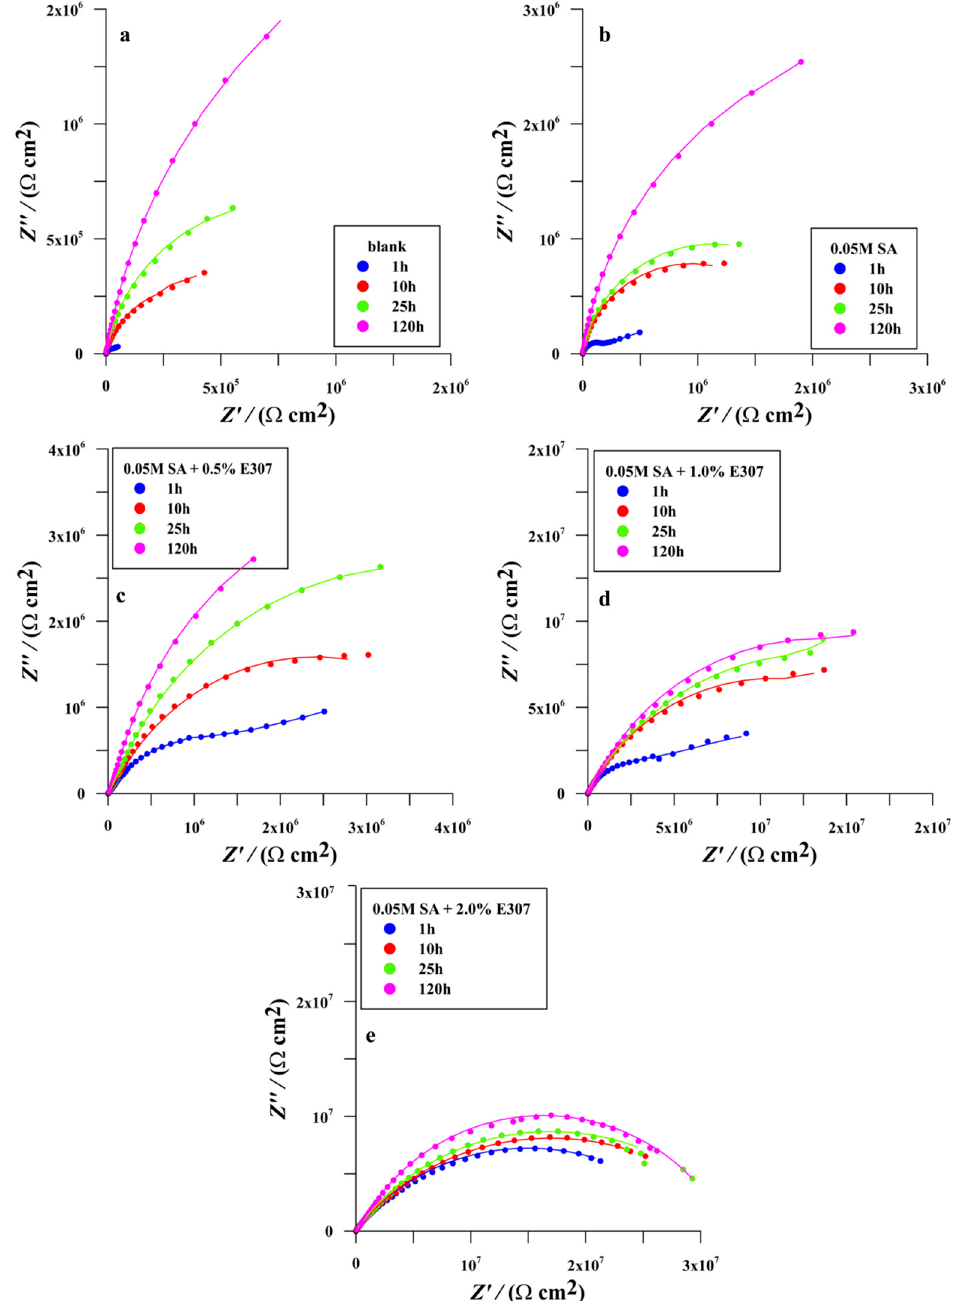
Figure 6. EIS Nyquist plots of SS AISI 410S samples for bare and modified surfaces measured after 1, 10, 25, and after 120 h of immersion at their open-circuit potential in a simulated solution of acid rain with pH = 3 at 25 ◦ C: ( a ) Blank, ( b ) SA, ( c ) (SA + 0.5% E307), ( d ) (SA + 1.0% E307) and ( e ) (SA + 2.0% E307) (measured data-dotted symbols and fitted data-solid